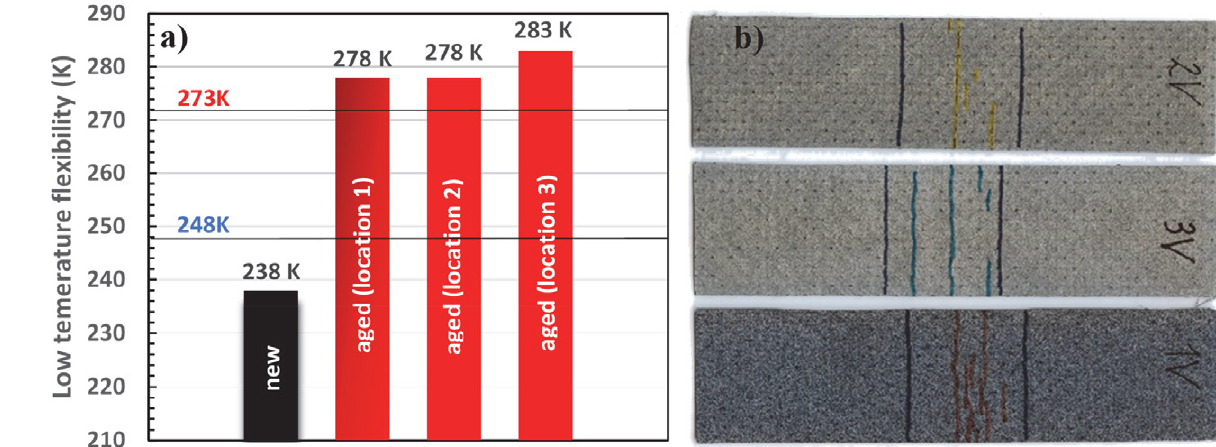
Figure 10. Results of the TGA-DSC analysis for new and aged membranes from location